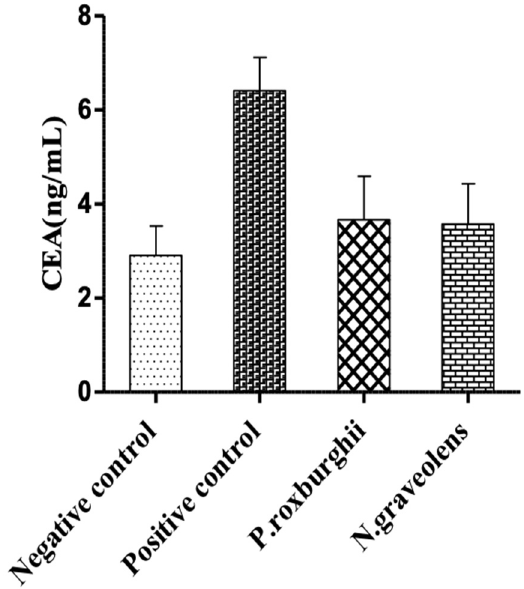
Figure 9. Level of serum CEA in different groups.